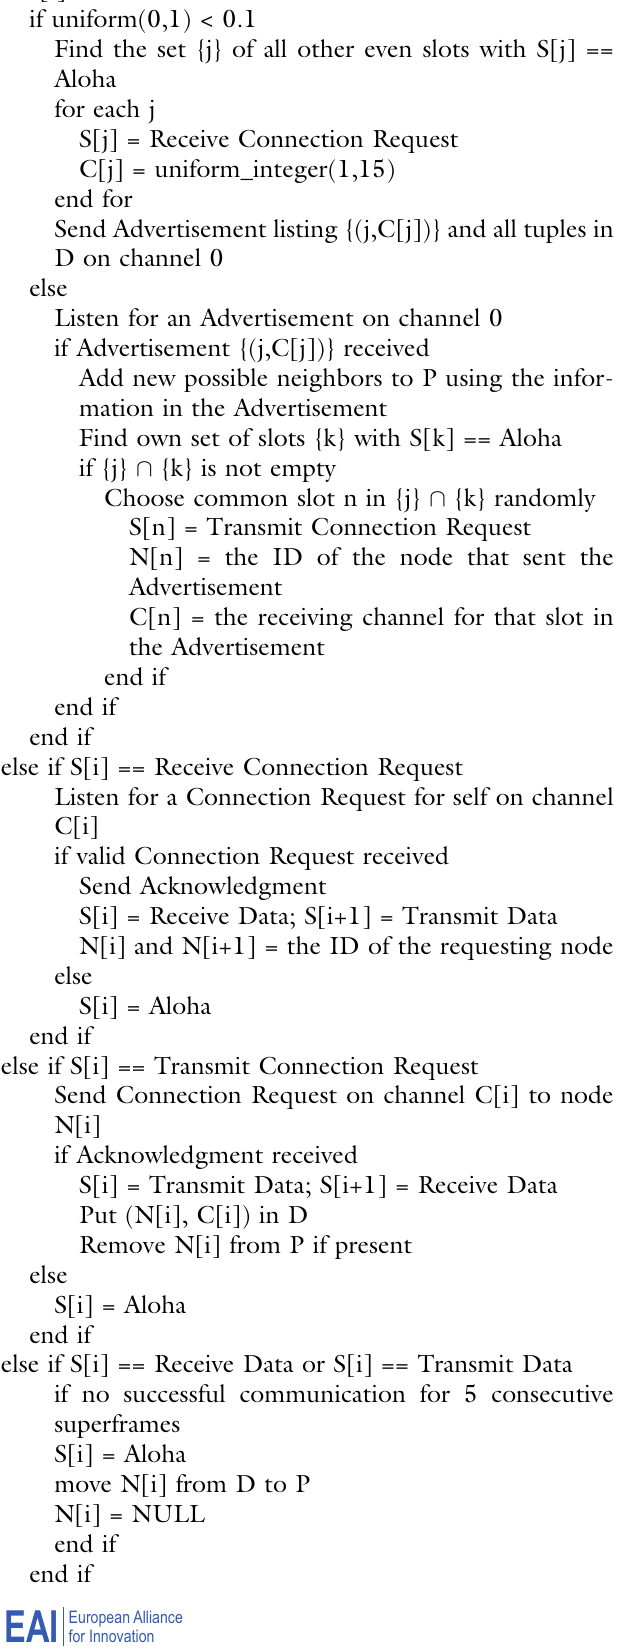
Algorithm 3: Reservation-Based Scheduling, Behavior for Slots other Than